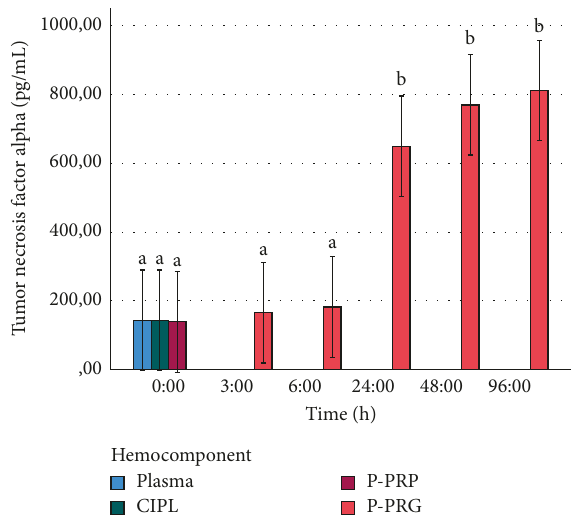
Figure 9: Mean ± SD temporal release of tumor necrosis factor alpha concentrations from P-PRGs to culture media. a–c Different lowercase letters denote significant ( P < 0 . 001) differences over the time by the Games–Howell post hoc